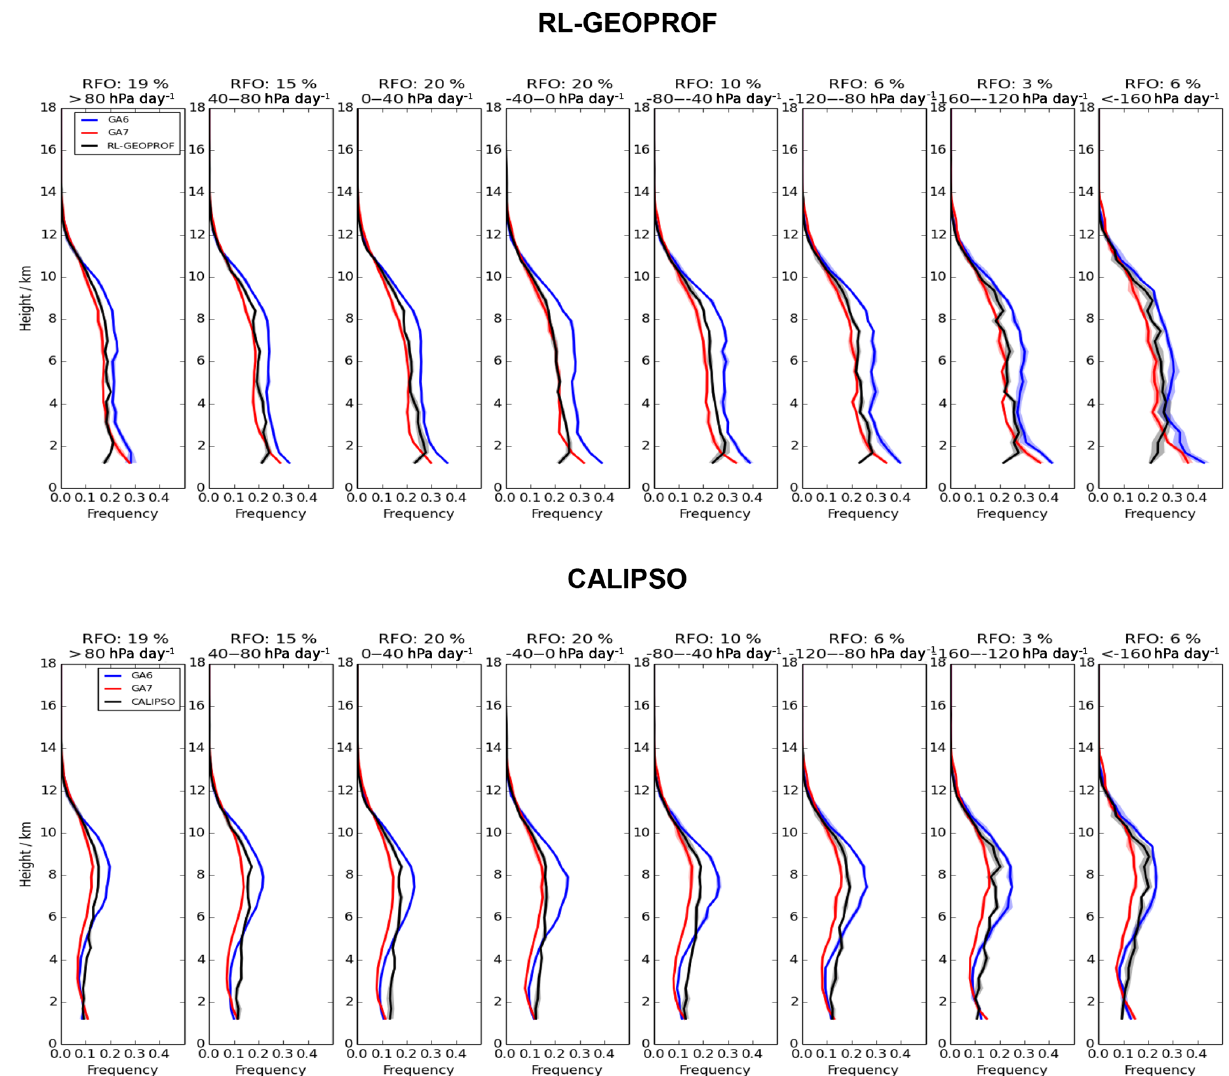
Figure 11. Observed and simulated RL-GEOPROF and CALIPSO height–frequency histograms composited by daily ω 500 over Northern Hemisphere land (polewards of 20 ◦ N) during DJF. The range and relative frequency of occurrence (RFO) are shown at the top of each bin. Shading around the line plots has been added to reflect significance bounds; however, this is sometimes less than the thickness of the plotted